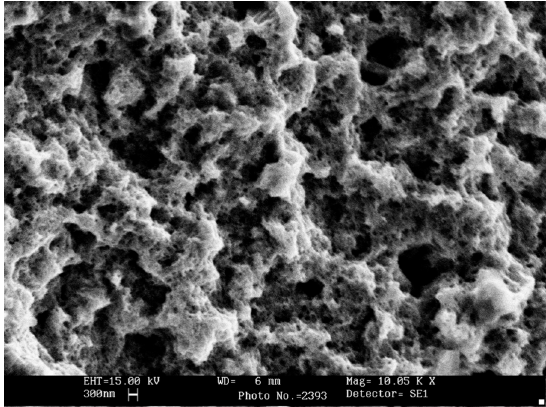
Figure 6. Microimages of a molybdenum wire cross ‐ section: ( a ) an original substrate after cross ‐ section preparation and its etching; ( b ) after electrolysis.